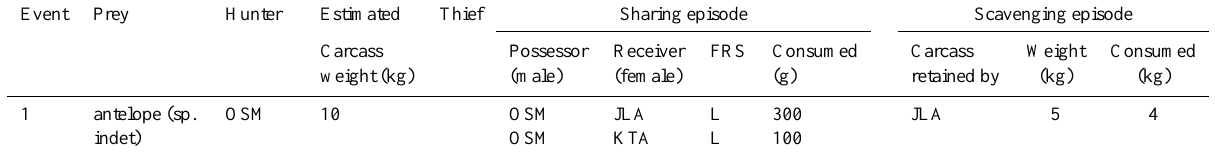
Table 2. Events of male hunting, intersexual meat sharing and scavenging episodes within Guinea baboon one male units. Event Prey Hunter Estimated Thief Sharing episode